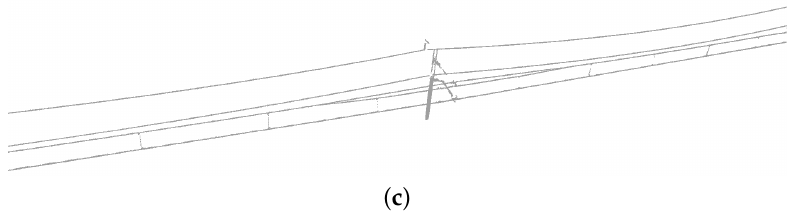
Figure 8. Results of iterative point partitioning: ( a ) ε 1 = 0.5 m; ( b ) ε 2 = 2 m; and ( c ) ε 3 = 7 m. The points grouped into regions are tagged with their region colors. Regions with the same color are related together for feature